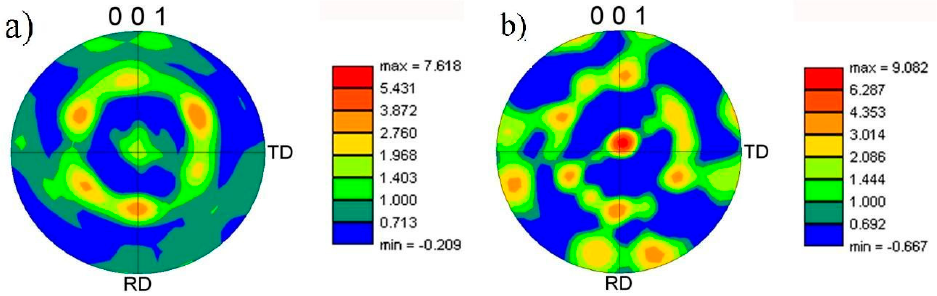
Figure 5. Direct pole figures [001] of ( a ) the AA6082 alloy and ( b ) the composite AA6082-0.2 wt % Al 2 O 3 after combined rolling.